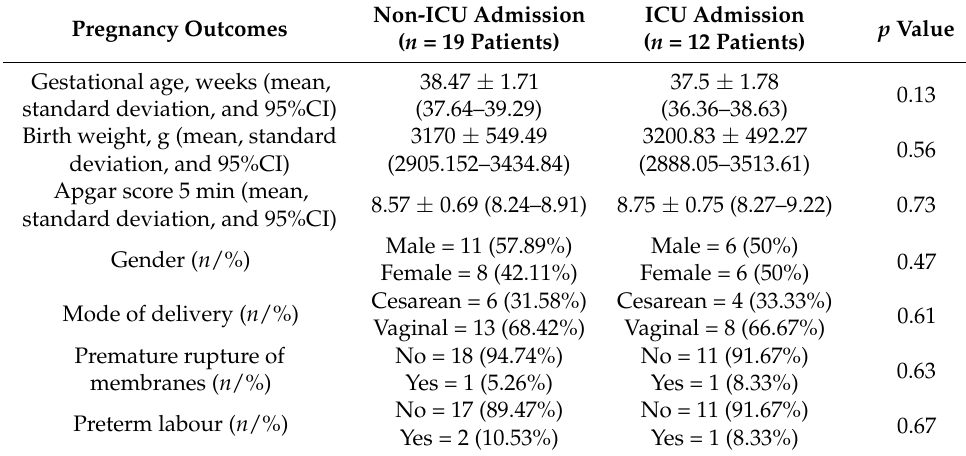
Table 7. The pregnancy outcomes for the two groups of patients included in the study. Pregnancy